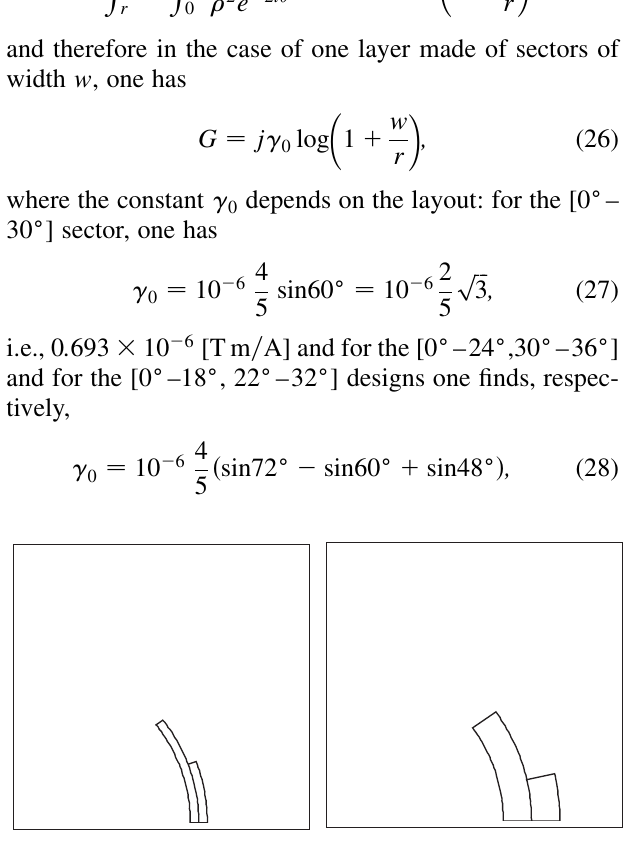
FIG. 9. Two shell layout solutions (cid:7) w=r (cid:2) 0 : 05 (left) and (cid:7) 6 (right) that set b